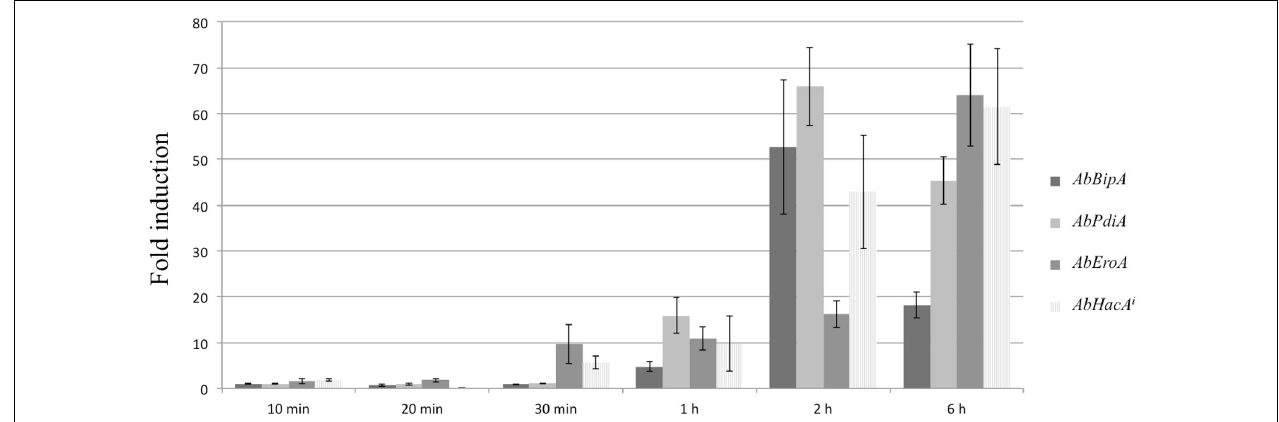
FIGURE 9 | Brassinin activation of the UPR signaling pathway. Quantitative RT-PCR results for the expression of UPR target genes ( AbBipA , AbPdiA , and AbEroA ) and the spliced AbHacA mRNA ( AbHacA i ) in an A. brassicicola wild-type strain during brassinin exposure (200 µ M) for 10, 20, and 30 min, 1, 2, and 6 h. For each target, expression induction is represented as a ratio (studied gene transcript abundance/actin transcript abundance) of its relative expression in each brassinin-treated sample to its relative expression in DMSO-treated cultures. The data are means of three repetitions. Error bars indicate standard deviations and asterisks indicate a relative expression significantly different from 1 (Student test, P <